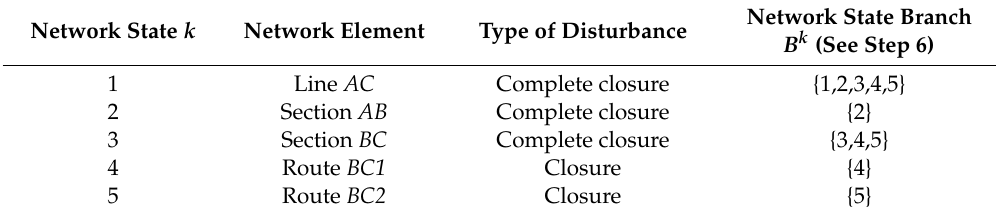
Table 3. Network states considered.